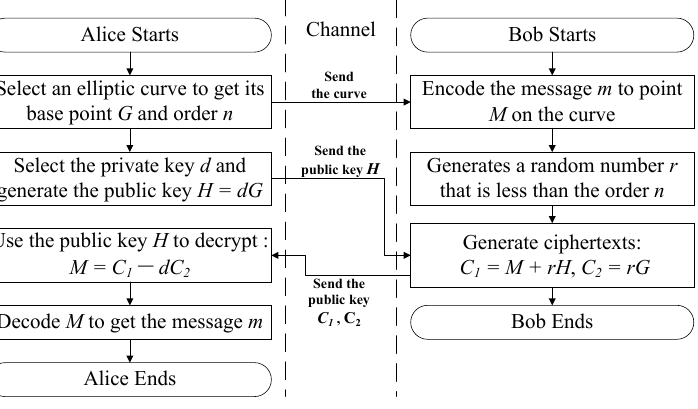
Figure 3. ECDH-based encryption and decryption